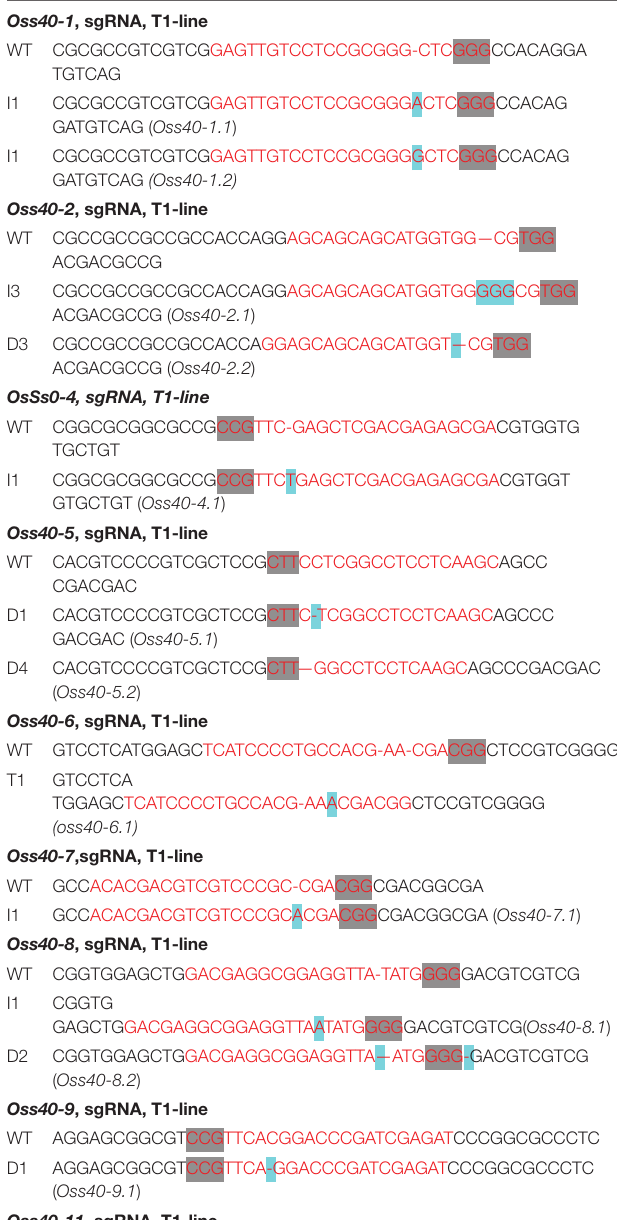
TABLE 1 | The targeted sequence region of OsS40 s CRISPR/Cas9-edited